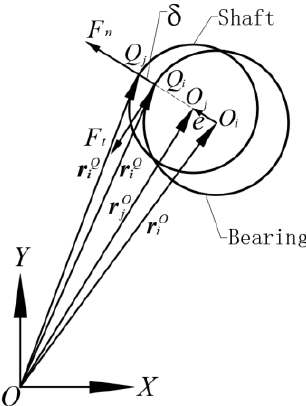
Figure 1. Revolute joint model with clearance.